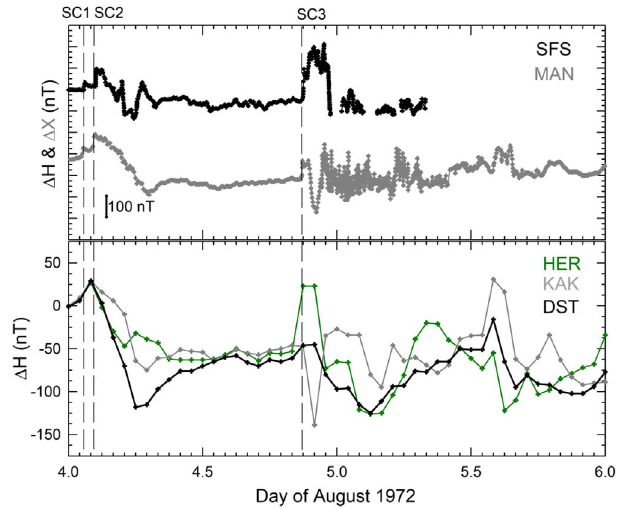
Fig. 1. Top panel shows the X - and H -components recorded at Manila and San Fernando magnetic observatories, respectively, from 4 to 6 August 1972. Data at San Fernando have been digitized from the original source and data at Manila have been digitized from Salcedo (1973) giant. Scanned magnetograms are included in Appendix A. Bottom panel shows hourly data of the H -component recorded at Kakioka (KAK, grey) and Hermanus (HER, green) magnetic observatories and the Dst index (black) from Kyoto World Data